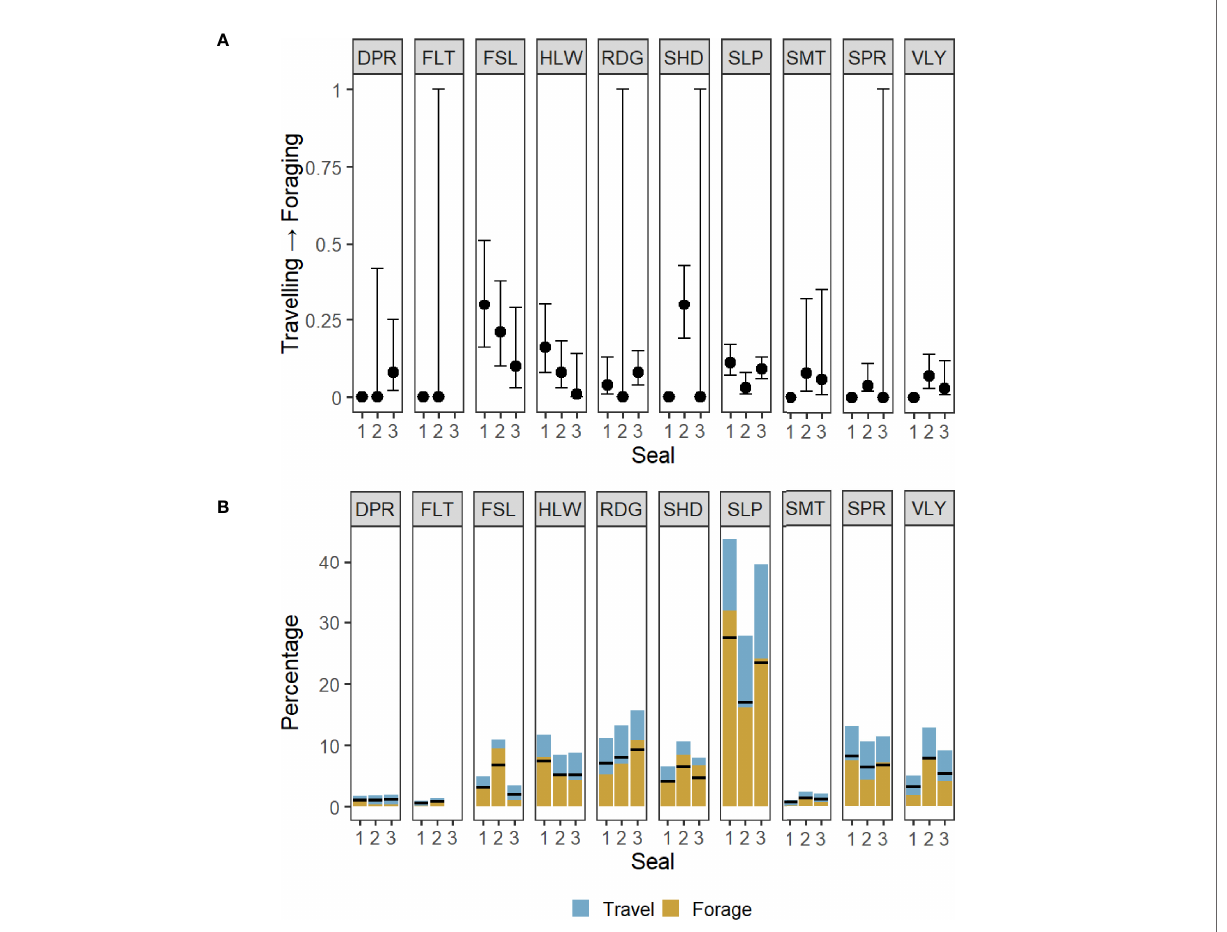
FIGURE 5 | (A) Mean transition probabilities between behavioural states inferred from the states assigned by the covariate HMM with 95% con fi dence intervals. There was an increased likelihood of switching from travelling to foraging for all three seals in association with the following geomorphons: footslope (FSL), slope (SLP) and hollow (HLW). Where the con fi dence intervals are 0, seals never transitioned out of the state they were in upon encountering that feature. But where CIs are wide (0-1), although there may have been an in fl uence of that feature on transitioning from foraging to travel, there was no instance of the seal transitioning out of travelling upon encountering that feature. (B) Percentage of total time (per seal) spent in foraging or travelling state at each feature type. Horizontal black bars show the relative mean percentage of time seals are expected to be in the foraging state based on activity budgets: Seal 1 = 63%, Seal 2 = 61%, Seal 3 = 59%. A disproportionately large amount of time was spent foraging over slope features for Seal 1, footslopes (FSL) and shoulders (SHD) for Seal 2, and ridges (RDG) and shoulders for Seal 3. For all feature type abbreviations see Table 3